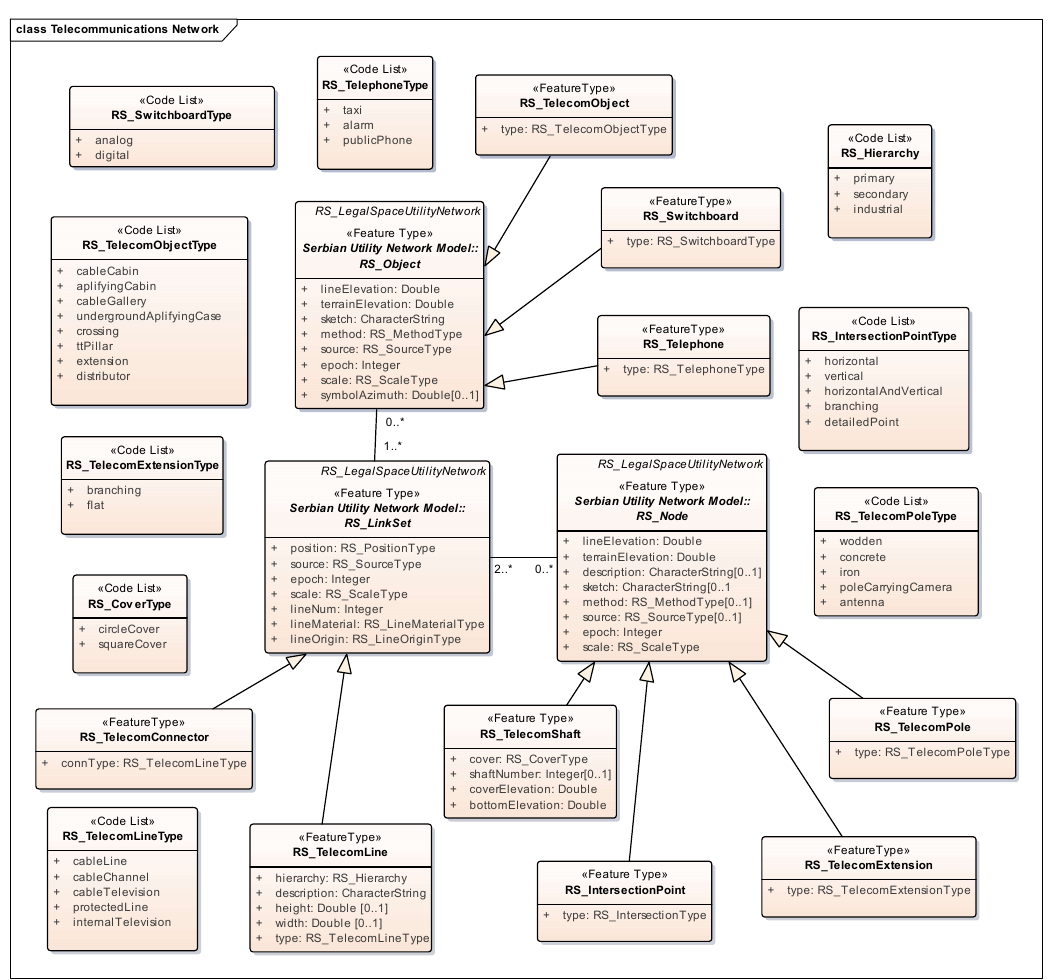
Figure 6. Specialization of the Serbian Utility Network Model for the telecommunications network.